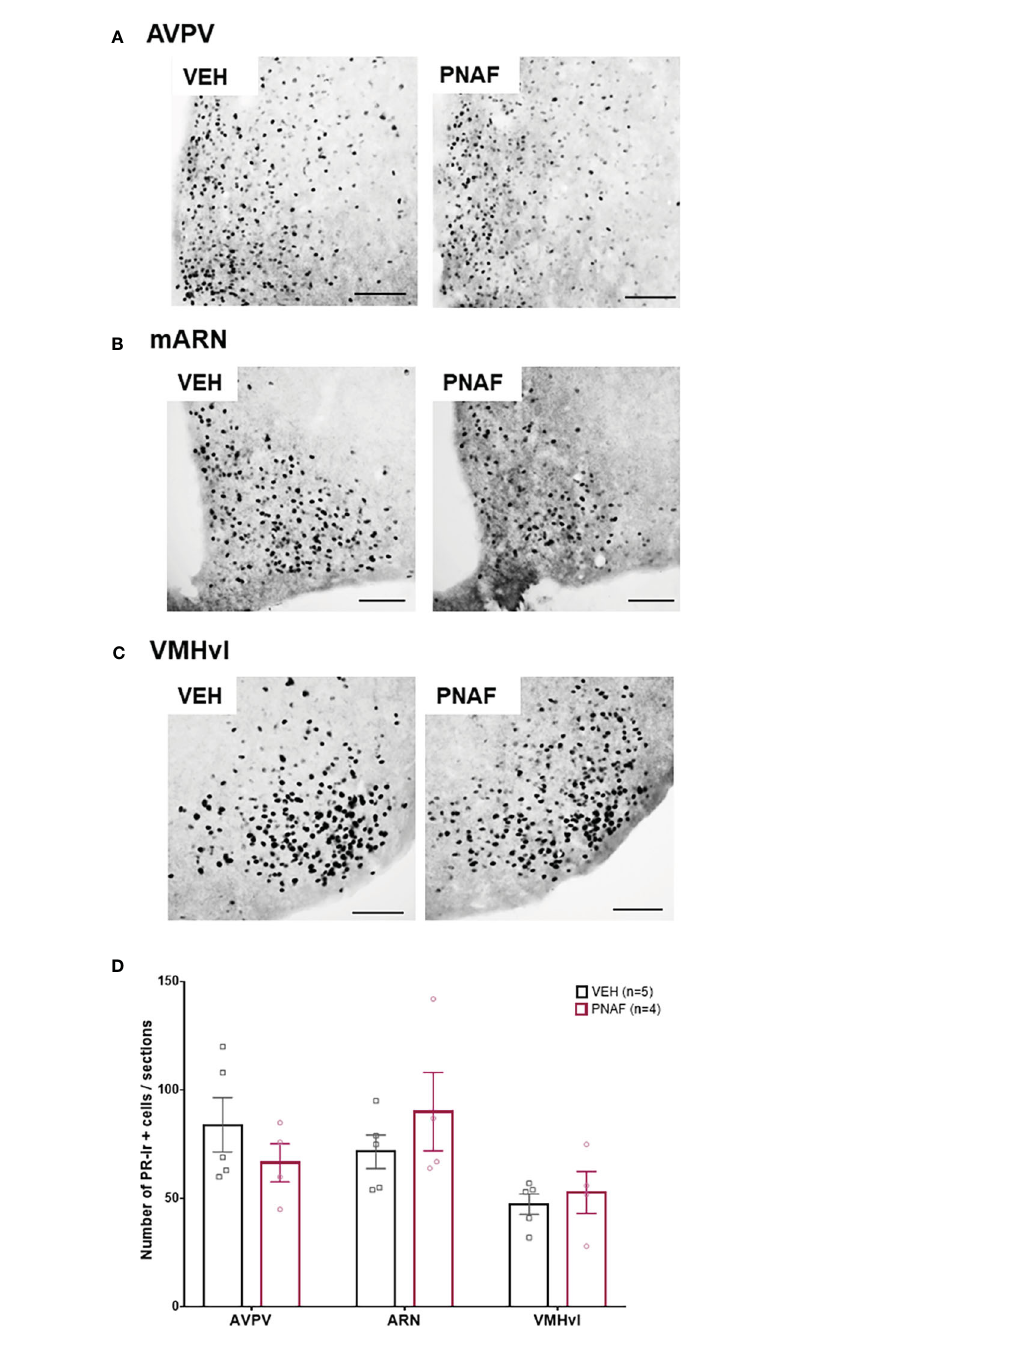
FIGURE 5 Prenatal DHT exposure does not alter adult progesterone receptor expression in after hormonal normalization. (A – C) Representative photomicrographs of PR immunoreactivity in the anteroventral part of the periventricular nucleus of the third ventricle (A) , the medial arcuate nucleus (B) and the ventrolateral part of the ventromedial hypothalamus (C) in VEH and PNA mice. (D) Histograms representing the number of Progesterone receptor (PR) immunoreactive cells per sections analyzed between ovariectomized and hormone replaced PNAF mice (magenta bars) and VEH female controls (black bars) within the three brain regions analyzed. AVPV, anteroventral part of the periventricular nucleus of the third ventricle; ARN, arcuate nucleus; VMHvl, ventrolateral part of the ventromedial hypothalamus. VEH, control female; PNAF, prenatally androgenized female modeling PCOS. Mean +/- SEM. Scale bar: 100 m